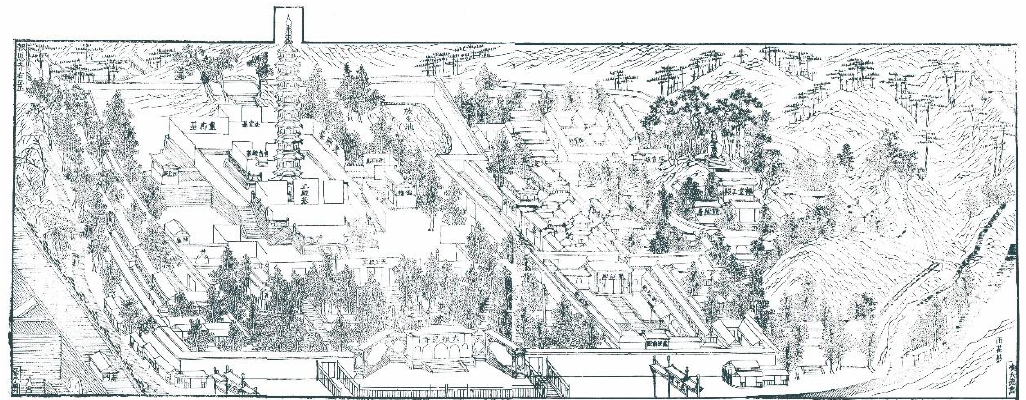
Figure 5. Overall view image of the Porcelain Tower in the book Jingling Fansha Zhi (source: Ref. [37]).